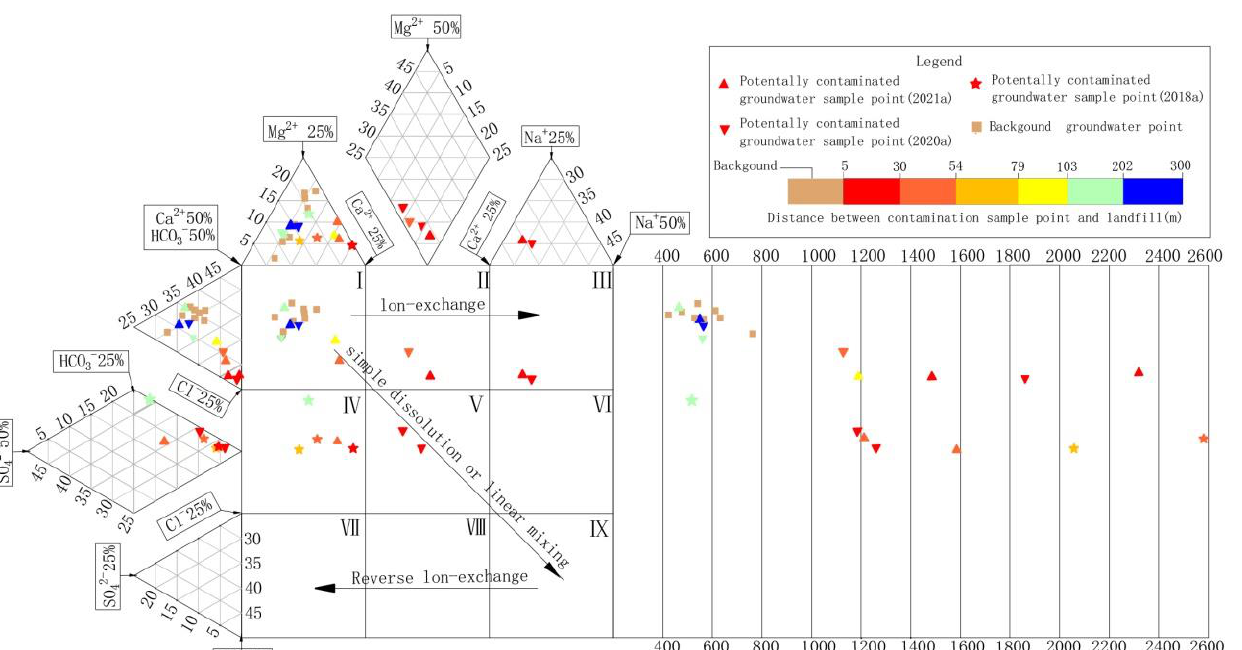
Figure 6. Milliequivalent concentration of Na + and Cl − in groundwater downstream of the landfill.